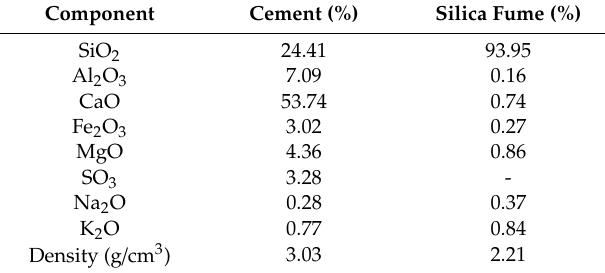
Table 1. Basic chemical composition of cement and silica